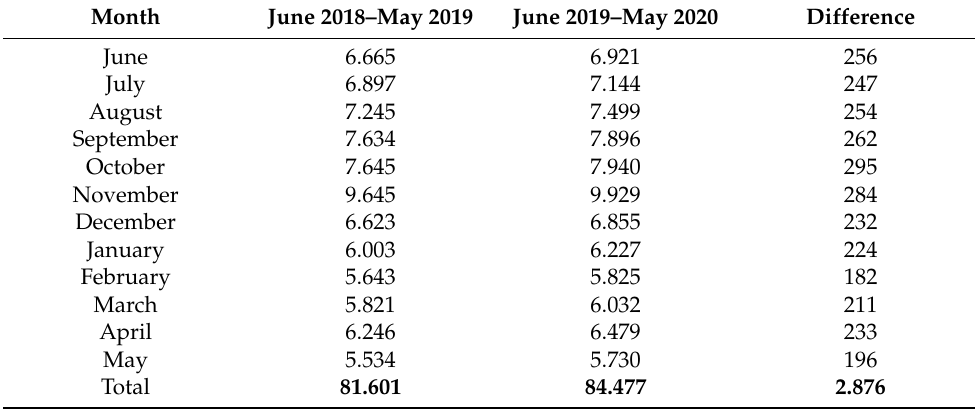
Table 12. Tourism demand predictions